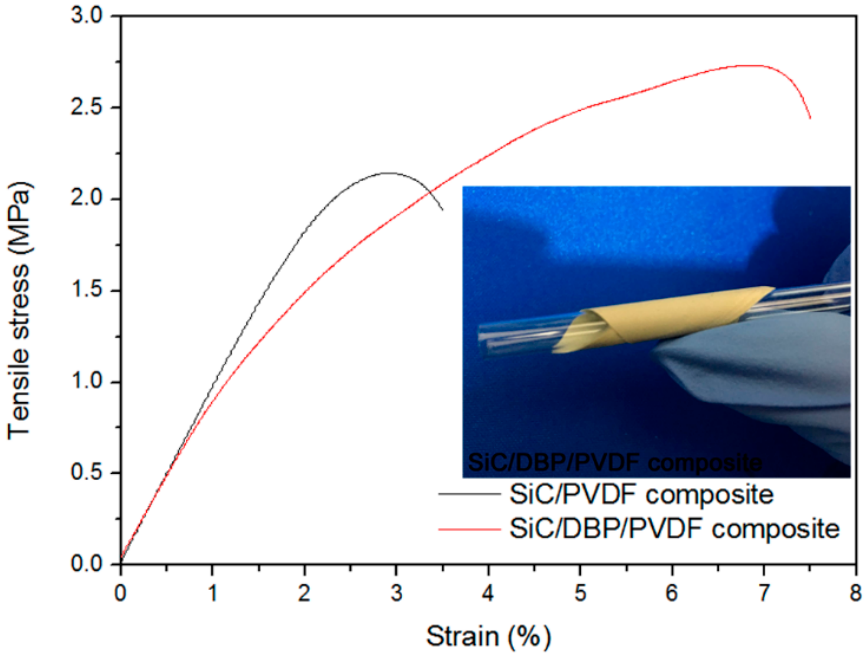
Figure 3. Stress-strain curves show higher mechanical property for the ternary composite compared with the binary composite, and NPs contents are both 36 vol %; the photograph shows the high flexibility for that ternary